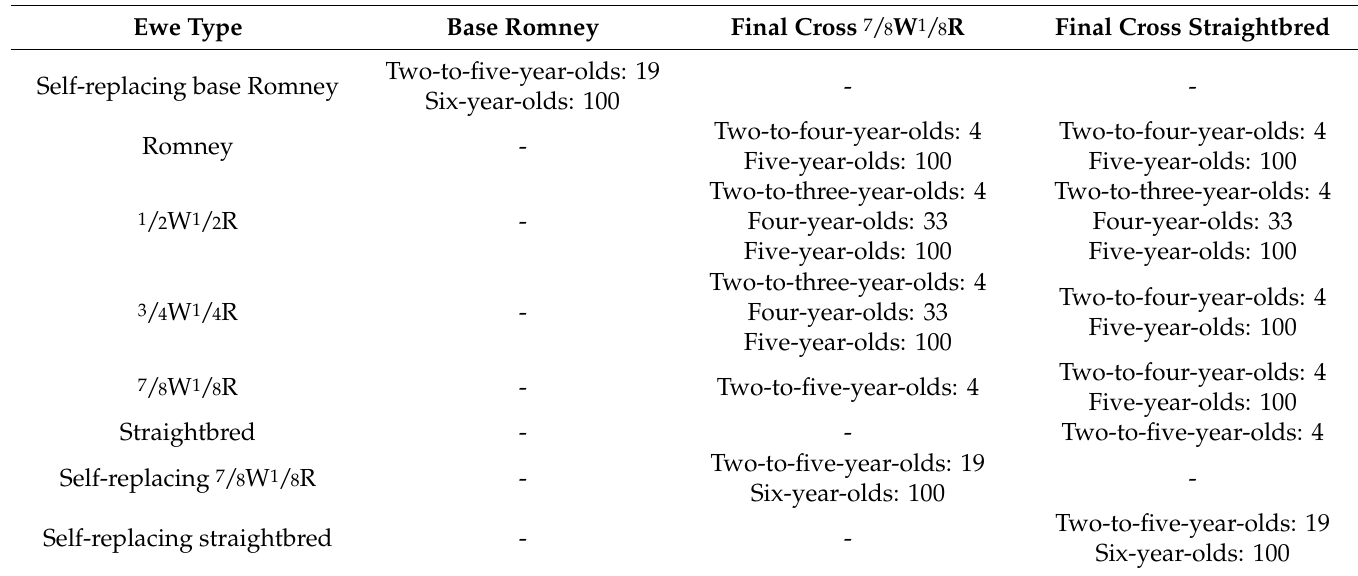
Table 1. Cull rates (%) for ewes of each age class and Wiltshire–Romney cross during the whole-flock breed grading up transition from Romney to a final cross of either 7 / 8 Wiltshire 1 / 8 Romney ( 7 / 8 W 1 / 8 R) or straightbred 1